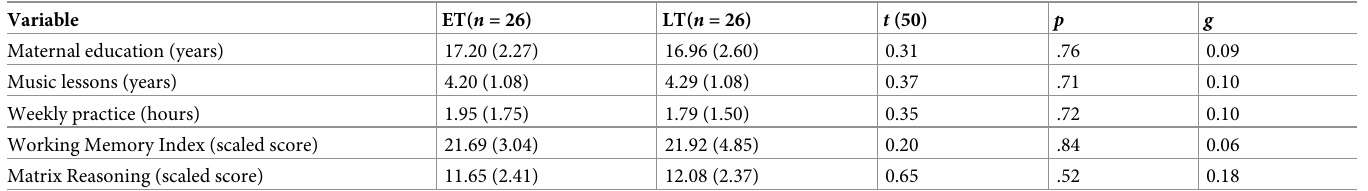
Table 3. Matched demographic, practice-related and cognitive variables in early-trained (ET) and late-trained (LT) musicians; ET < 7 � LT (n = 52). Variable